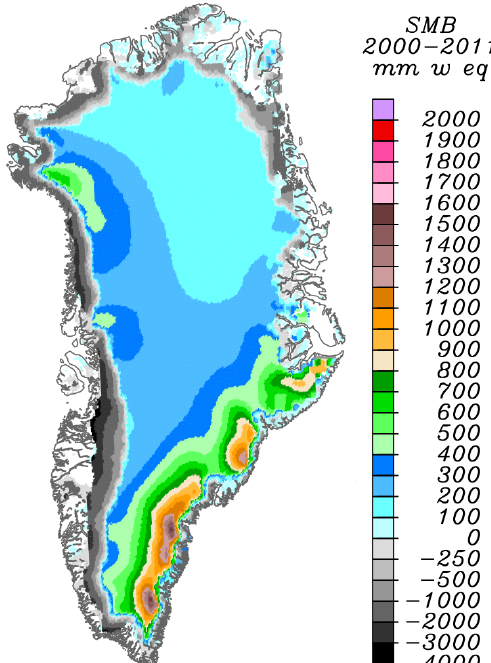
Fig. 4. Surface mass balance averaged spanning the 12yr of this study (2000–2011) according to MAR simulations. Grey tones in- dicate the ablation area. Colored regions indicate the accumulation